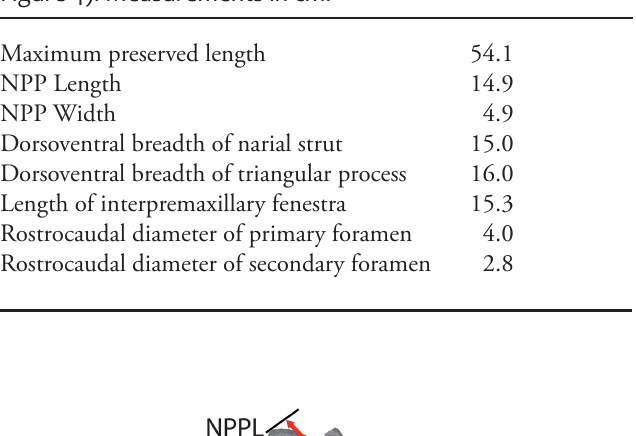
Table 1 . Select measurements for MOR 1122 7-22-00-1 (see Figure 4). Measurements in cm.